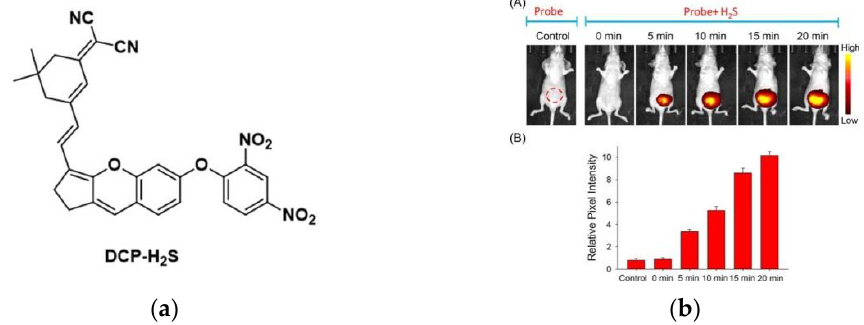
Figure 30. ( a ) Structure of probe DCP-H 2 S; ( b ) Fluorescence imaging of DCP-H 2 S in normal and tumor-bearing mice. Reproduced with permission from [123]. Copyright 2022 American Chemical Society.